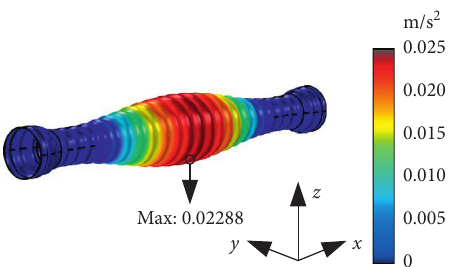
Figure 11: The acceleration of the busbar shell at 2900Hz in COMSOL.